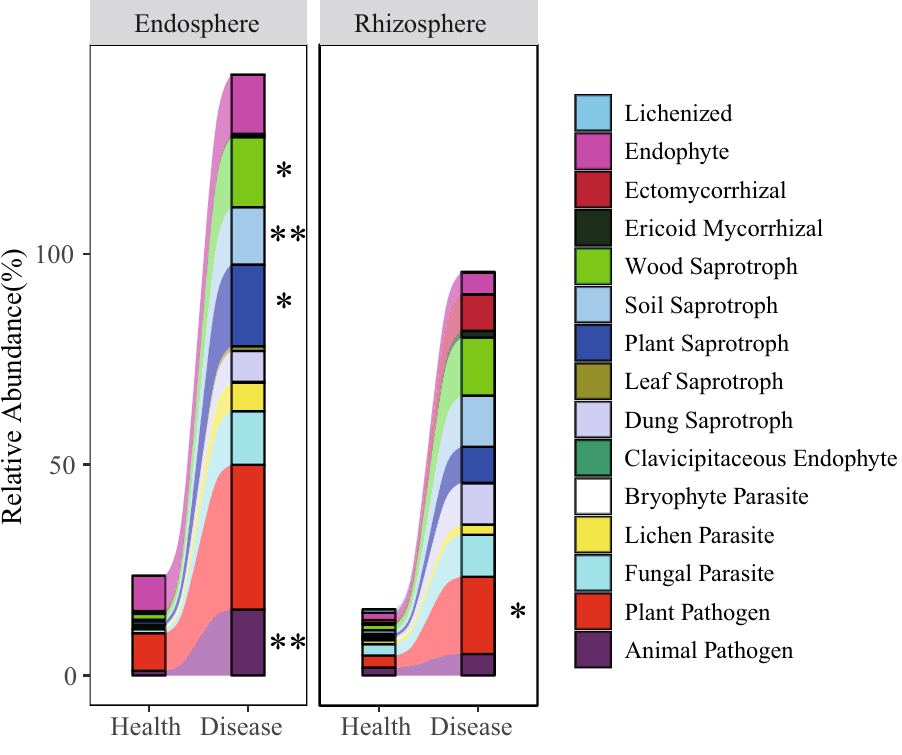
Figure 2. Stacked shock map of the functional group distribution of the fungal community in the rhizosphere and the endosphere of diseased and healthy Cc . *0.01 < P ≤ 0.05; ** P ≤ 0.01 (Welch’s t